Question: Based on the figure, does the quantity rise or fall?
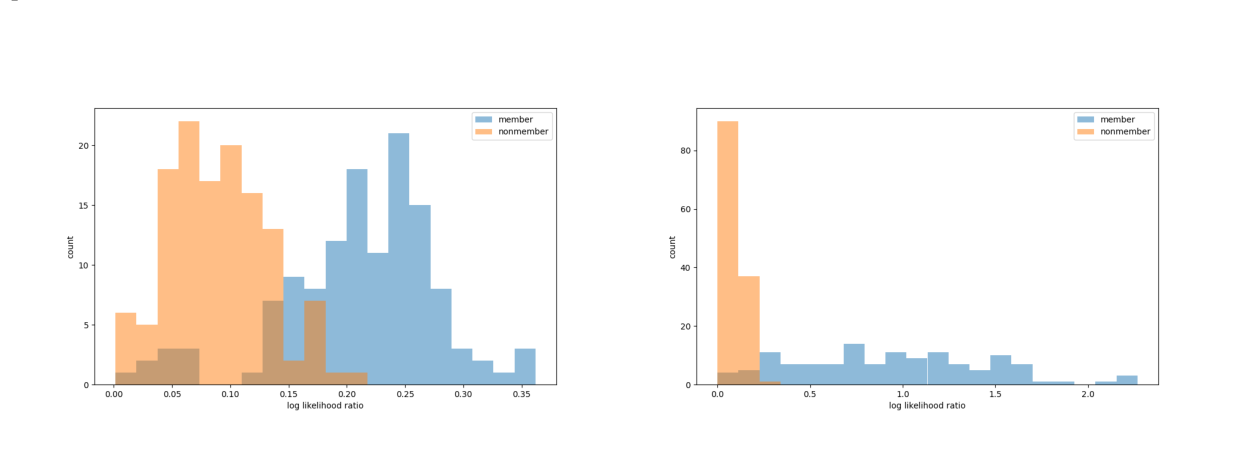
Answer: increasing